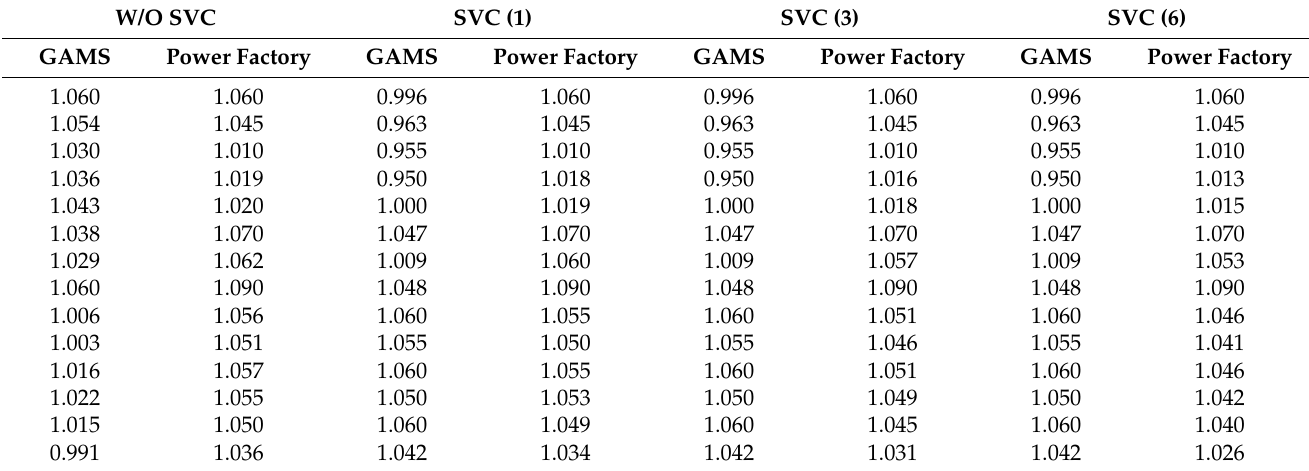
Table 2. Comparison of the voltage profile in the 14-node scheme. GAMS vs. Power Factory.